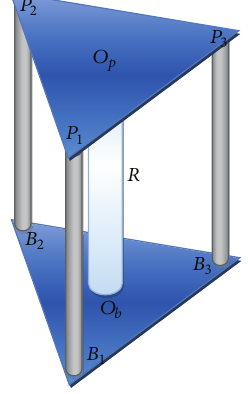
Figure 1: Proposed model configuration.